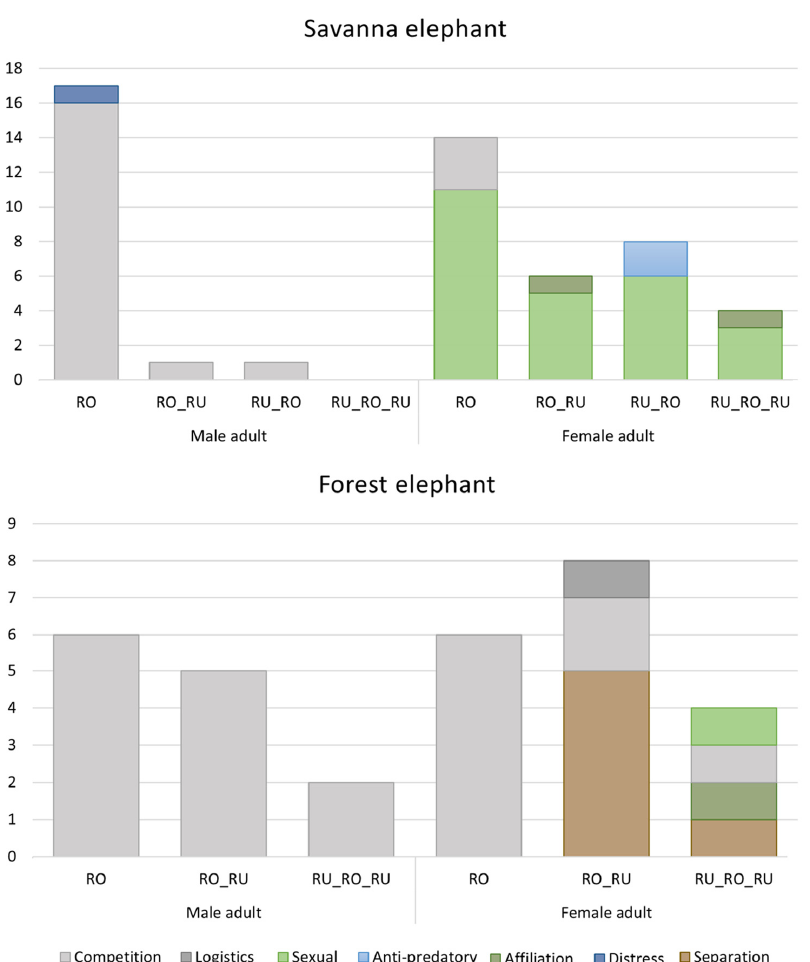
Figure 5. Number of roars used singularly, and roar-rumble combinations produced in different contexts by adult male and female savanna and forest elephants (savanna elephants: N = 51; forest elephants: N =